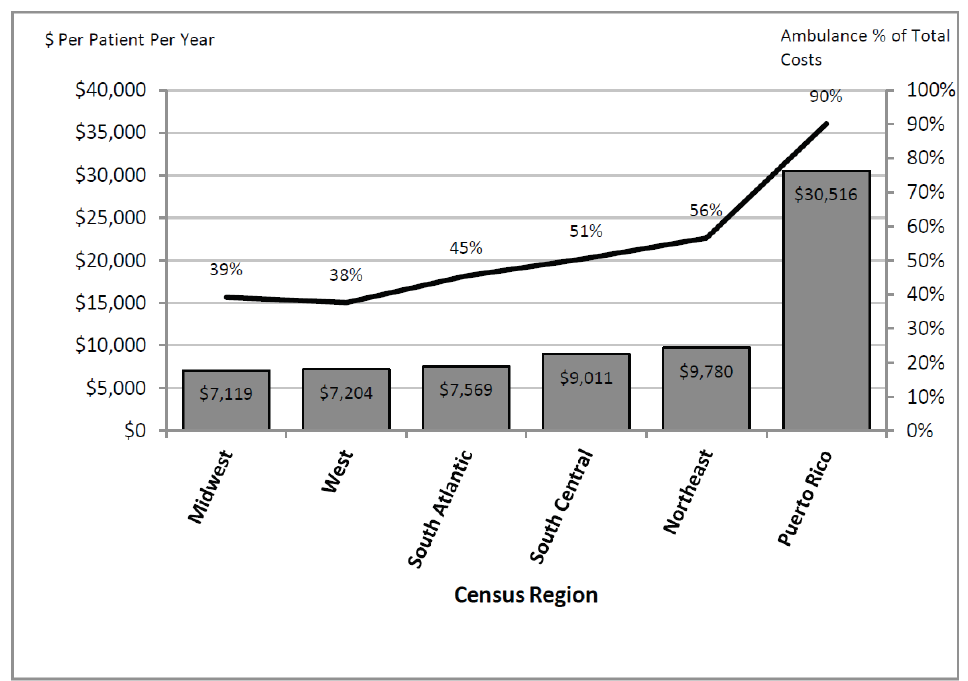
Figure 2. Dialysis Transportation Costs PPPY and Percent of Costs Attributable to Ambulance Trips, by Census